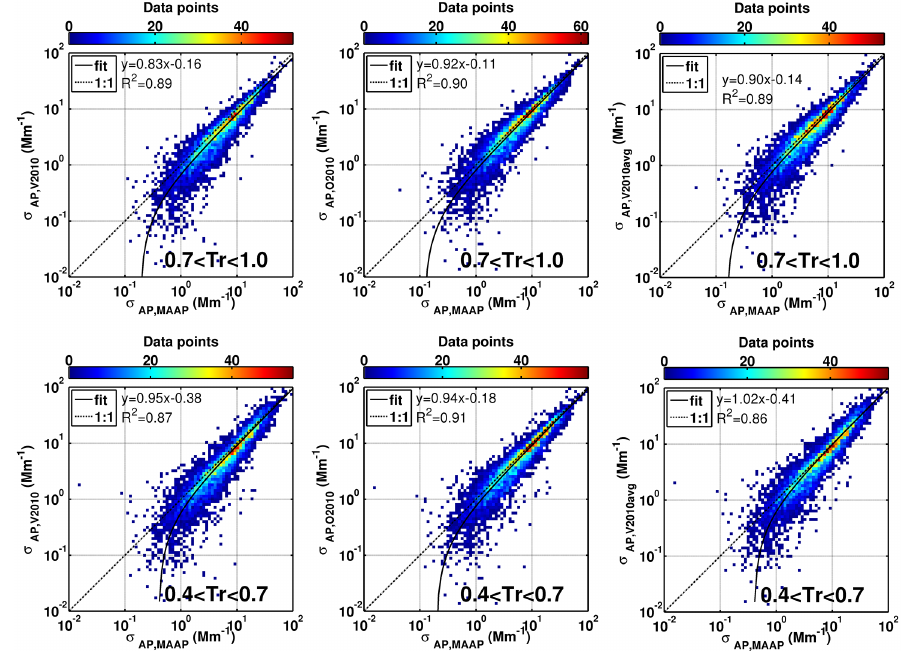
Figure 3. The relationship between light-absorption coefficients measured by the MAAP ( σ AP,MAAP ) and PSAP ( σ AP,V2010 , σ AP,O2010 and σ AP,V2010avg ). The upper and lower panels show data with a Tr range of 0.7–1.0 and 0.4–0.7, respectively. The integration time of the data plotted is 1h. The colour legends indicate the number of data points in the scatter plot at a given coordinate. The linear regression was done using the bivariate method.